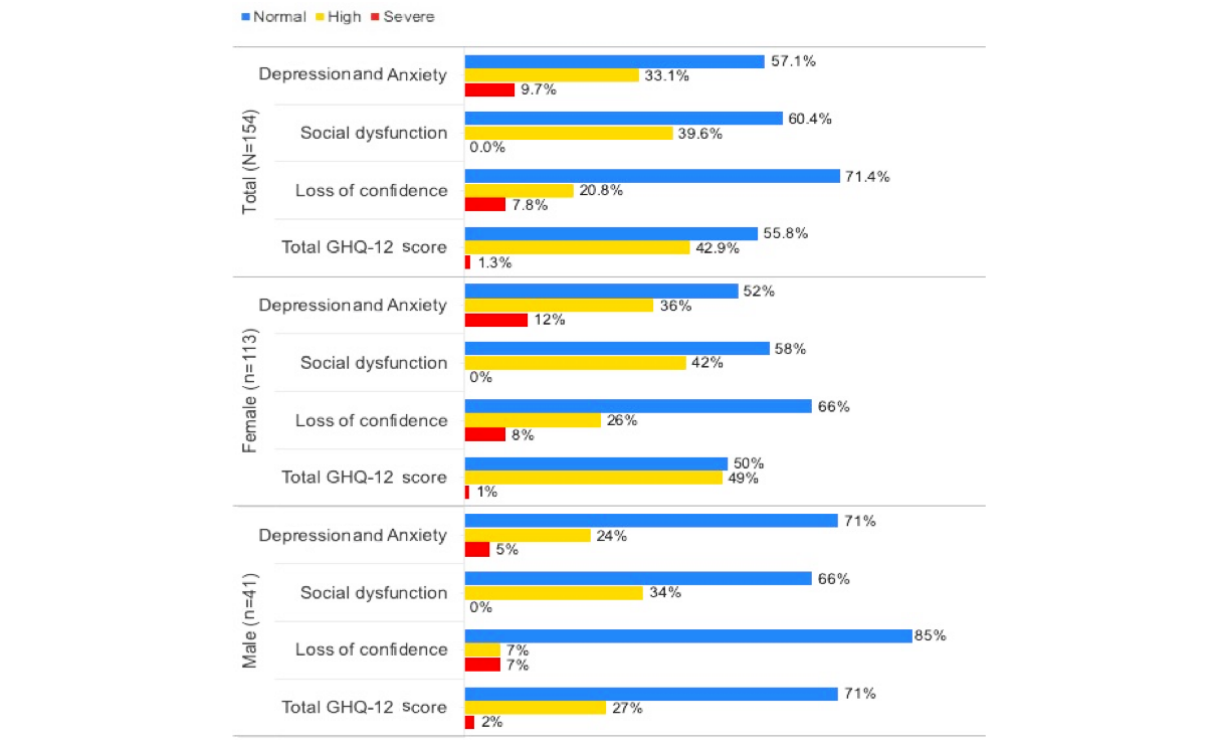
Figure 2. Classification of GHQ-12 answers by severity category and gender. GHQ-12: 12-item General Health